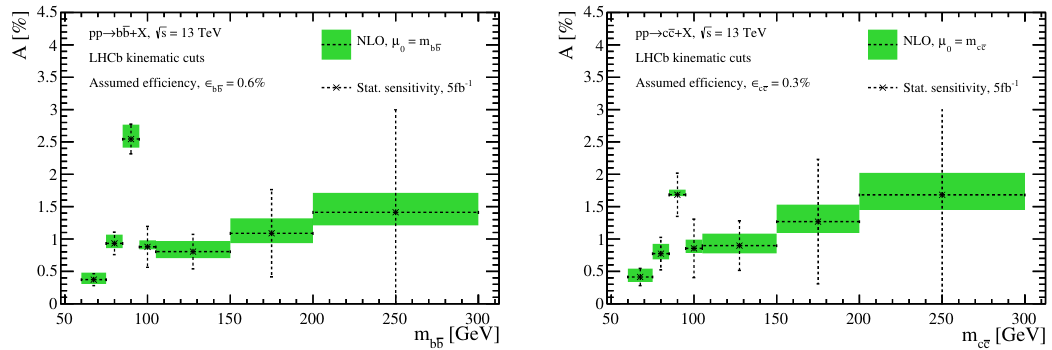
Figure 7 . Di(cid:11)erential asymmetry for b - (left) and c -jet (right) pairs within the LHCb (cid:12)ducial p region (2.2) at s = 13 TeV. The shown NLO distributions are obtained with the scale choice (cid:22) 0 = m , and the estimated statistical sensitivity of a future measurement at LHCb with 5 fb (cid:0) 1 Q (cid:22) Q of integrated luminosity has been